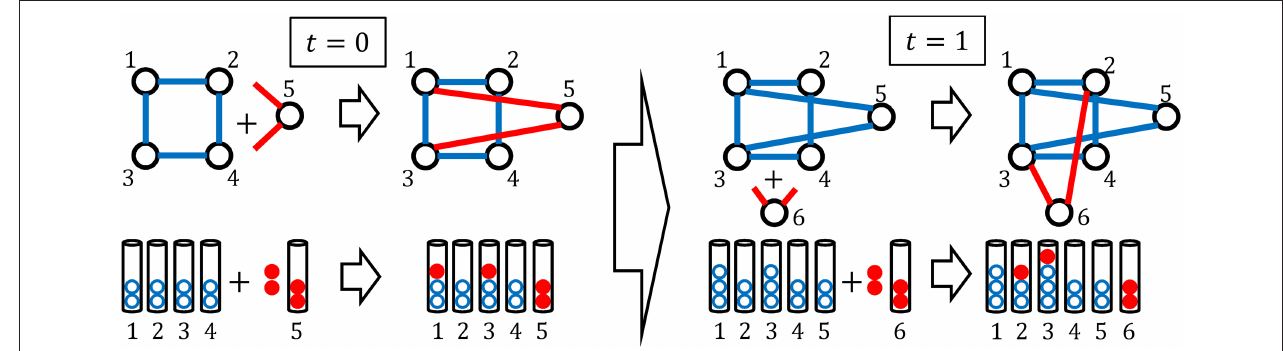
FIGURE 7 | An example of the BA model with k 0